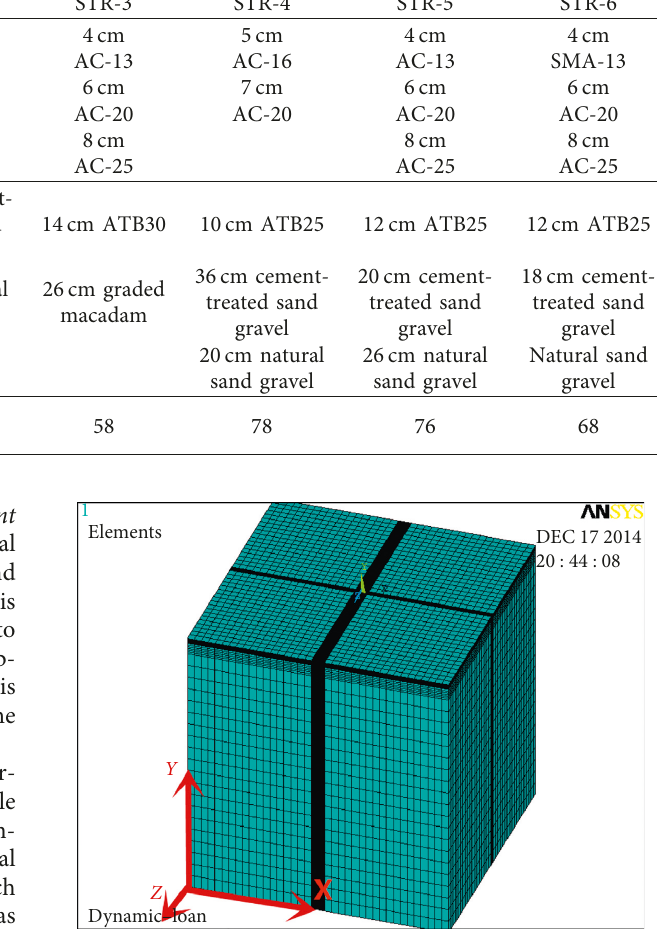
Figure 7: The FE model used in this